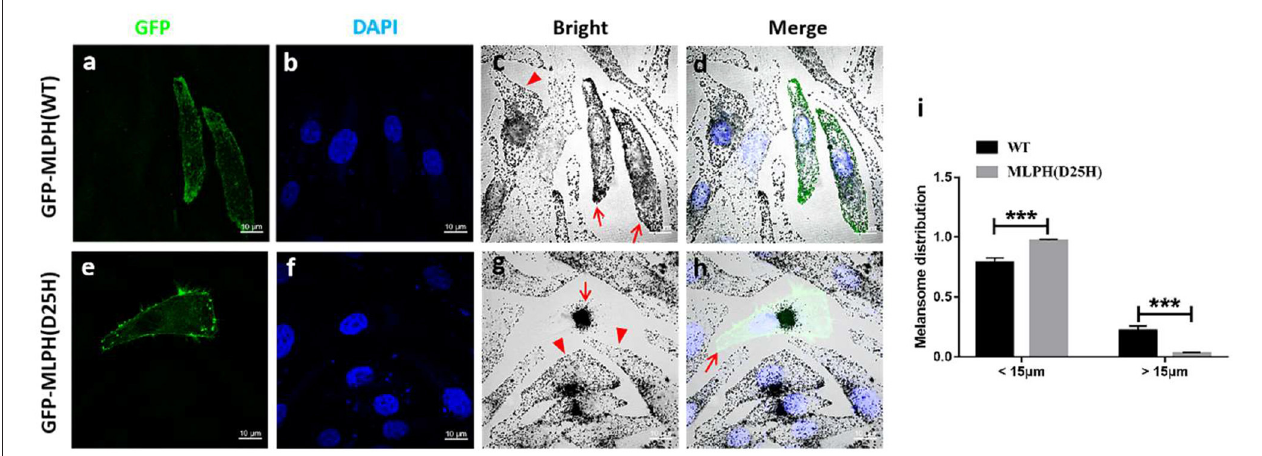
FIGURE 4 | The mutant MLPH (D25H) induces perinuclear melanosome accumulation in MNT1 cell by bright-field microscopy. (a–h) Images of transfected cells. Green fluorescence protein (GFP) [ (a,e), green] represents the transfected cells. Blue staining represents DAPI-labeled nuclei (b,f) . Melanocytes transfected with GFP-MLPH (WT) show the presence of pigmented melanosomes in the cell peripheral [ (c,d) , red arrows], while melanocytes transfected with GFP-MLPH (D25H) show a perinuclear aggregation of melanosomes [ (g) , red arrow] and the absence of melanosomes in peripheral region [ (h) , red arrow]. Cells failed to transfect with GFP-MLPH (WT) [ (c) , red arrowhead] or GFP-MLPH (D25H) [ (g) , red arrowheads] show a normal peripheral melanosome distribution. Bars: 10 µ m. (i) Quantification of melanosome radial profile distribution. Melanosome distribution was quantified using Image J plugin radial profile. The radial melanosome intensity from each cell was quantified by drawing an equally-sized circle around its entire area. Percentage distribution of “perinuclear” melanosome ( < 15 µ m) and “peripheral” melanosome ( > 15 µ m) was calculated. In total, 11 cells in each group were analyzed. Quantified data were presented as mean ± standard error of the mean (SEM) using Student’s t -test. Error bars indicate SEM (*** p < 0.001).